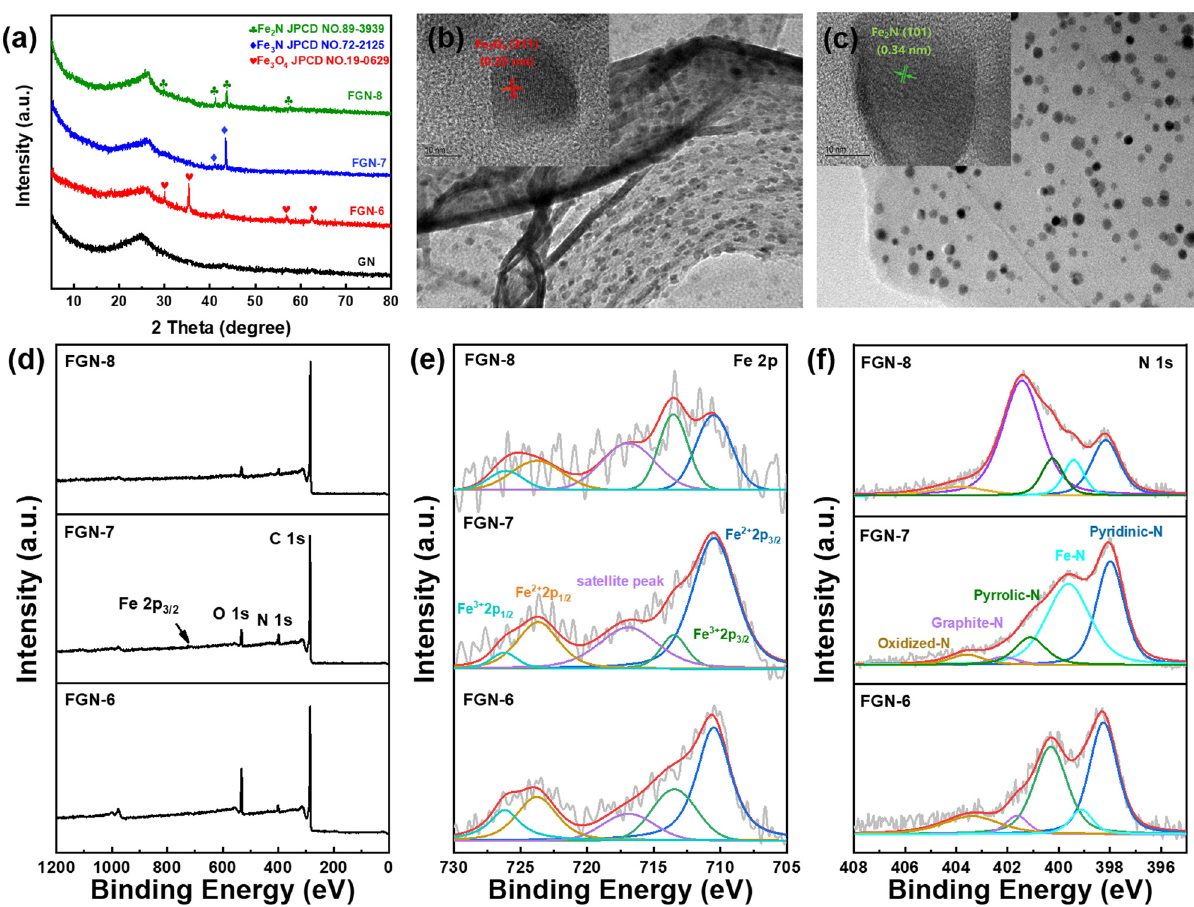
Figure 3: ( a ) XRD spectra of GN, FGN - 6, FGN - 7, and FGN - 8; TEM and HRTEM of ( b ) FGN - 6; ( c ) FGN - 8; ( d ) the XPS survey spectrum, ( e ) Fe 2p; (